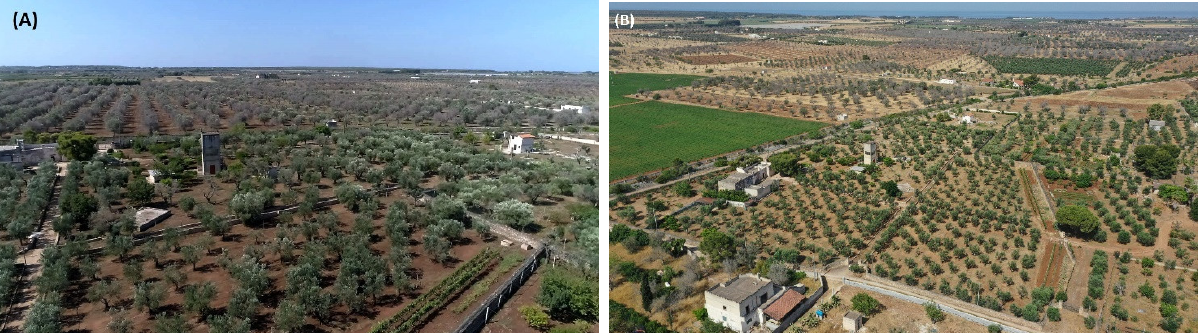
Figure 15. Neighboring olive groves at Nardò (Lecce province). In panel ( A ), during June 2019, the olive grove in the lower part of the image had the control strategy applied and the trees appear healthy, whereas the olive grove in upper part of the image had cultivation abandoned and the trees appear completely withered. Panel ( B ) shows the situation in June 2022. The olive grove that has continued to apply the control strategy (lower part of the image) still continues to produce oil with the local cultivars, whereas the neighboring farm replaced olive trees with tomato (on the left). In the background, other olive groves appear completely withered.